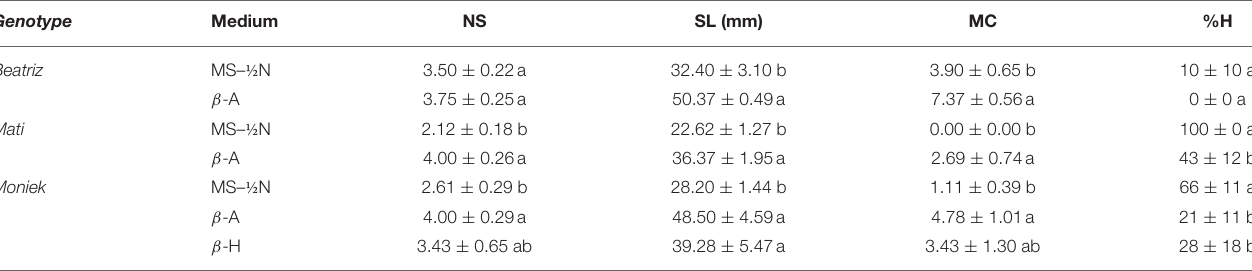
TABLE 1 | Effect of the culture medium (MS– ½ N, β -A, and β -H) on the proliferation of apical sections of Beatriz, Mati, and Moniek shoots cultured in RITA ® vessels.